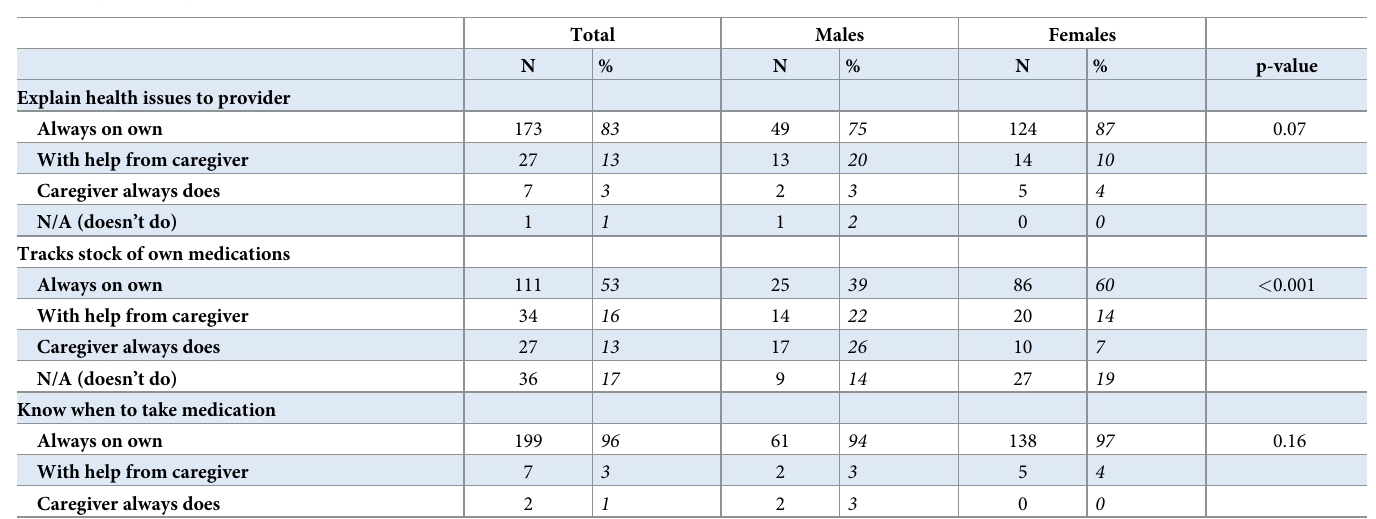
relationships reported knowing their partner’s HIV status (13% of males and 55% of females, p < 0.001). Most ALHIV (89%) reported that none of their friends knew they were living with HIV. Community engagement. A third (32%) of all ALHIV reported involvement in youth organizations, including choirs or church groups, activist or youth associations, sports teams, or other arts groups (Table 3). Thirty-five percent reported cultural or religious organization participation and 22% reported participation in sports.